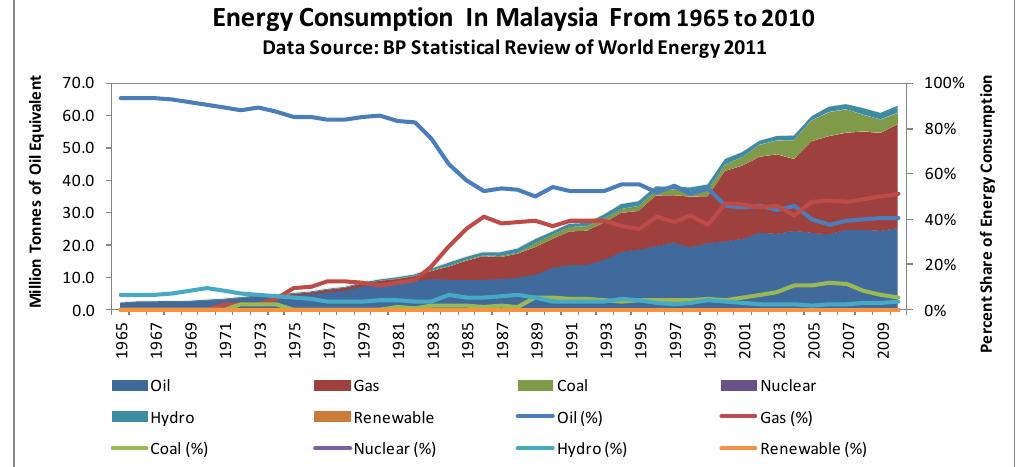
Figure 5. The chart depicts the energy consumption trend in Malaysia from 1965 to 2010. The line graphs are the percent energy share while the shaded areas represent the absolute energy consumption in Million Tonnes of Oil Equivalent. Over the years gas has become a prominent source of energy and successfully reducing the country’s dependence on oil. Petroleum are the major sources of energy consumed in Malaysia for the last 45 years without any significant advances in the area of renewable energy. The above trend is not sustainable from an environmental and resource availability perspective. Data were obtained from [24] and plotted by the